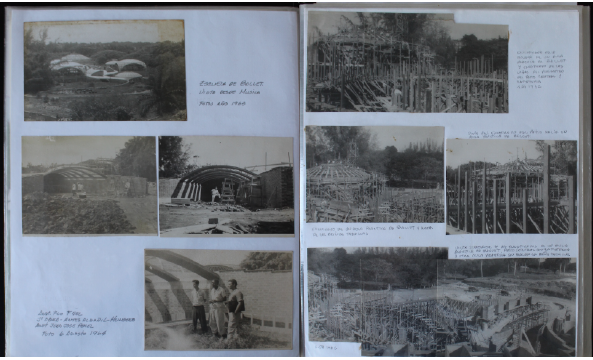
Figure 9. Example page of primary construction